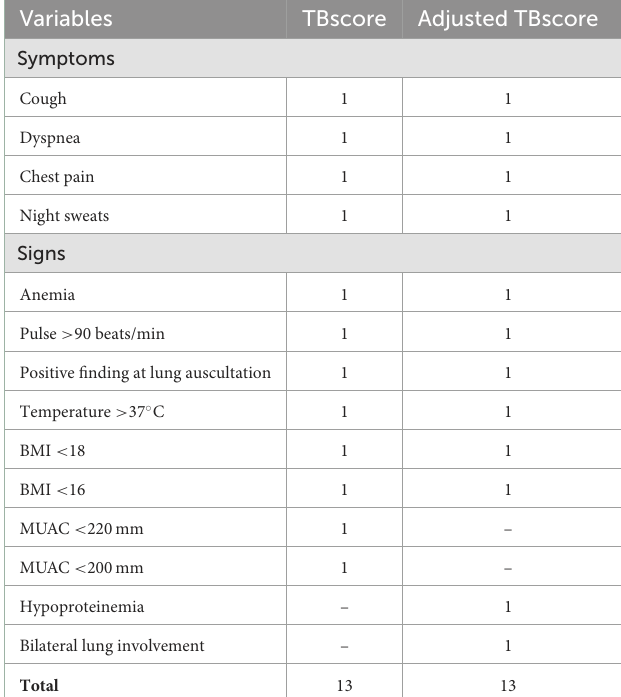
TABLE 1 TBscore and adjusted TBscore. TABLE 2 Characteristics of patients and factors related to smoking at the time of TB